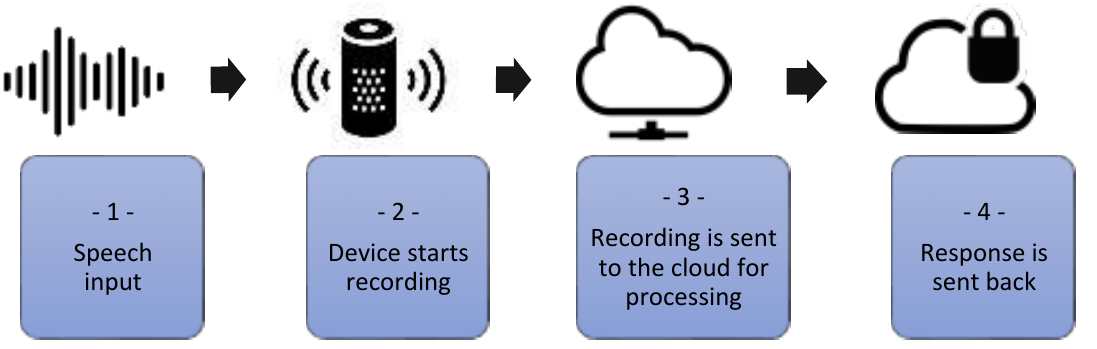
Figure 1. AI speaker’s workflow.